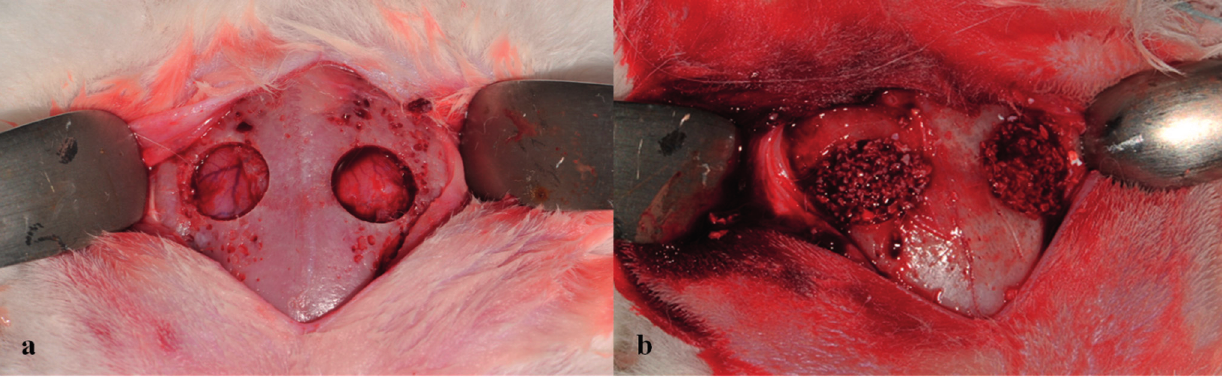
Figure 9. Formation of calvarial defect (8 mm diameter) and implantation of experimental materials. ( a ) two defects were formed with trephine bur; ( b ) defect areas were implant with or without Bio-Oss ® or BMP-2/Bio-Oss ®